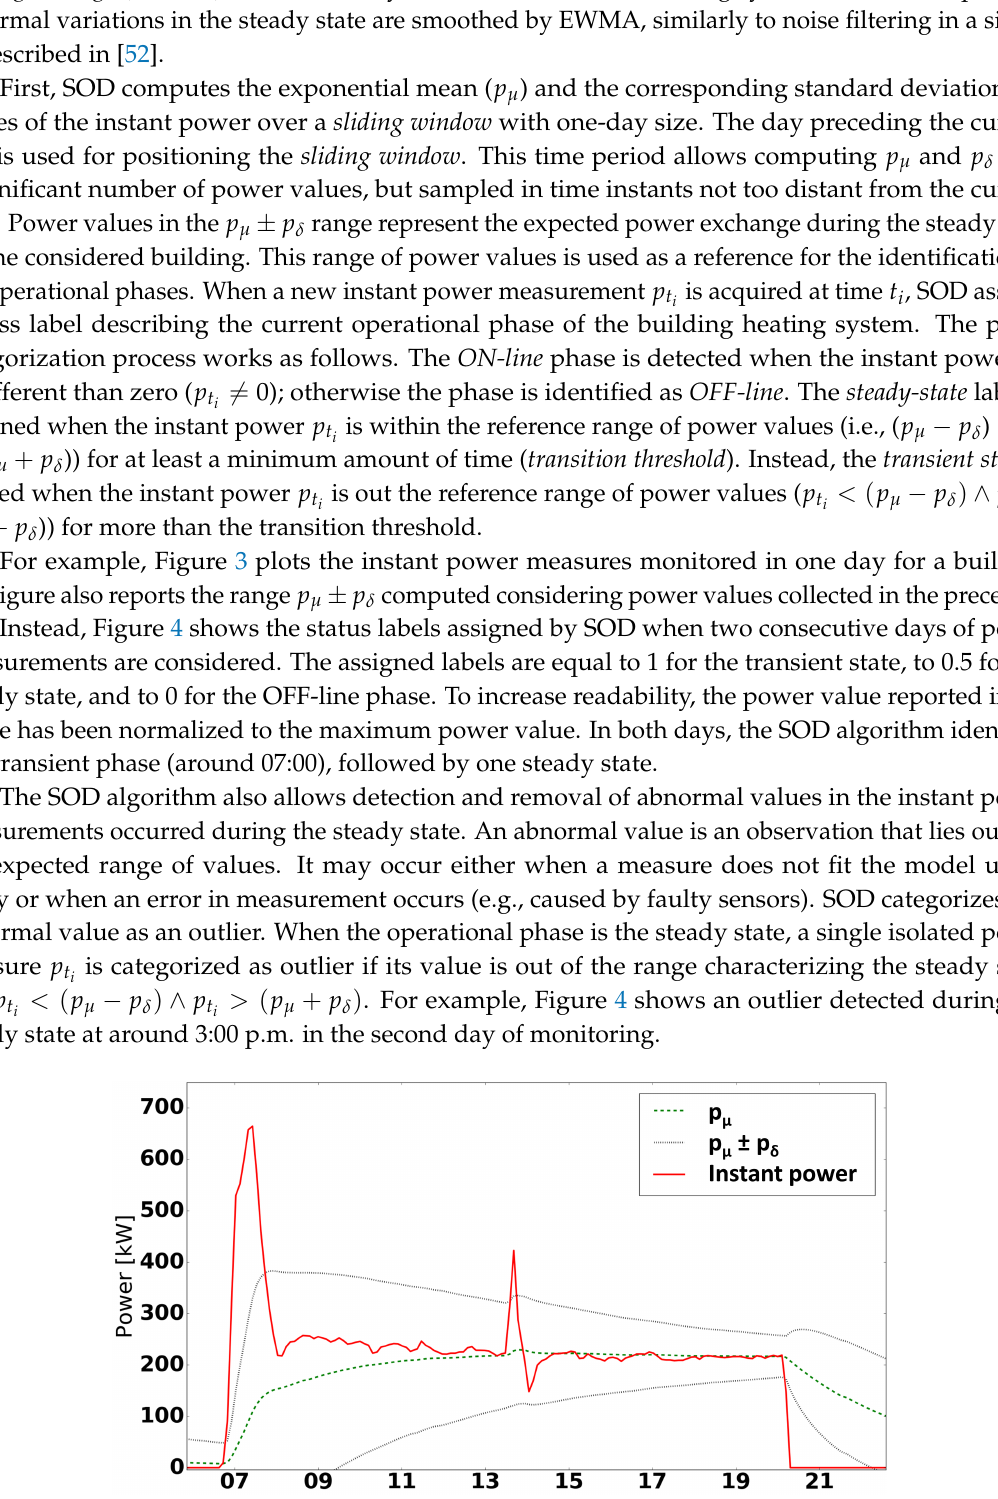
Figure 3. Daily instant power profile against the expected power range during the steady state ( p µ ± p δ